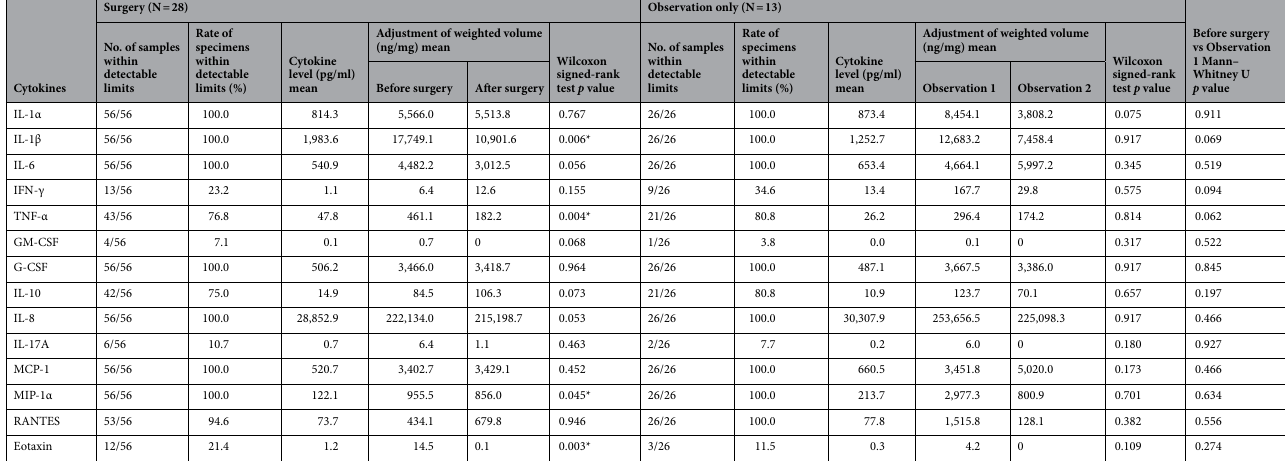
Table 5. Comparison of cytokine levels between groups. Cytokine levels assessed according to our report 25 and adjusted by weighted volume in the cervical mucus. * p < 0.05 by Wilcoxon signed-rank test.